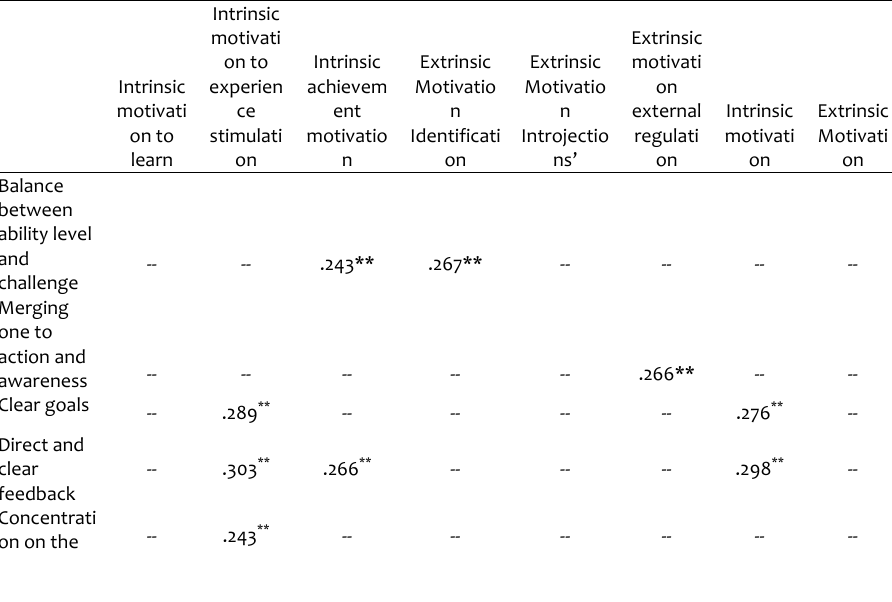
Table 8. Correlations between motivation and Flow State for music